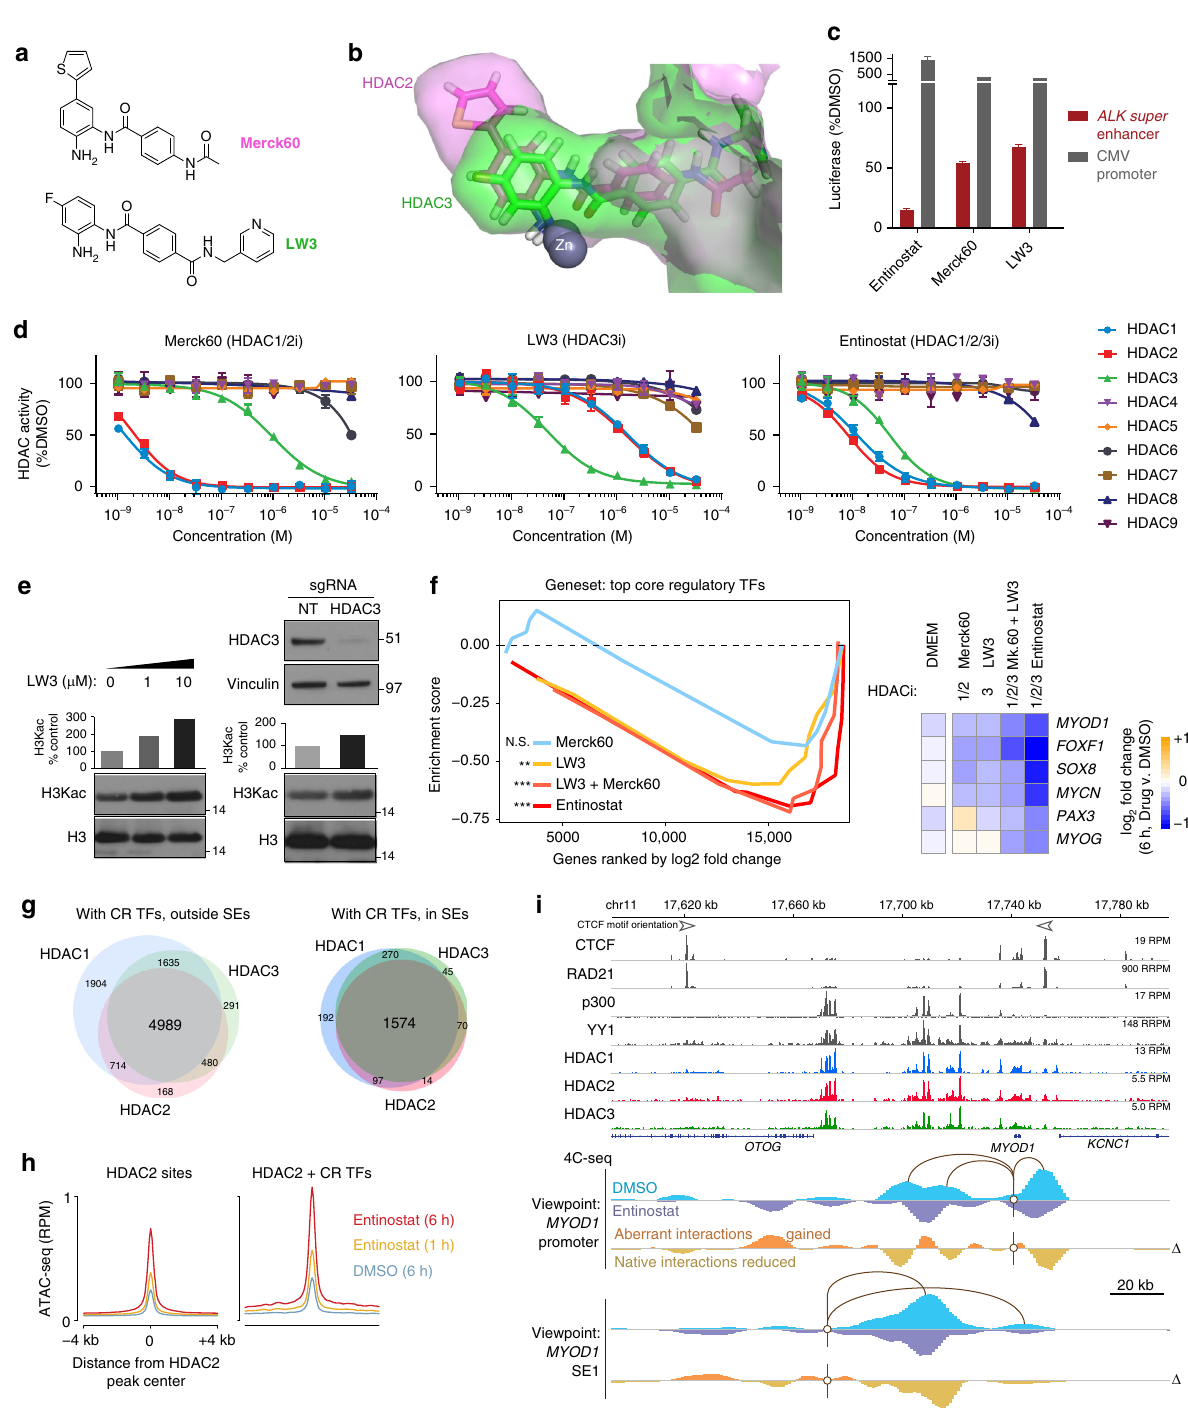
gained4C-seq DMSO Entinostat Viewpoint: MYOD1 reducedAberrant interactions promoter Viewpoint: